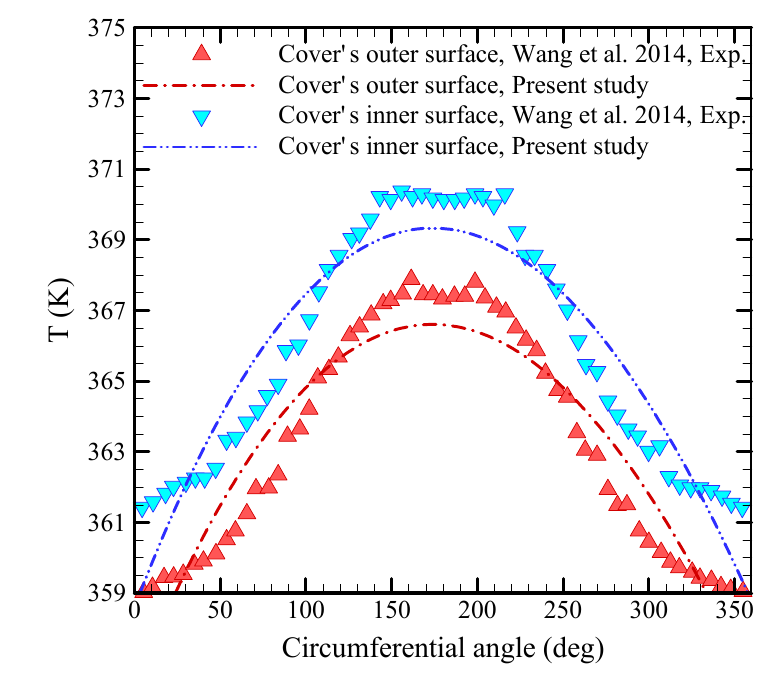
Figure 4. ( a ) Grid mesh. ( b ) Code validation among present work results and experimental data of Wang et al. [34].